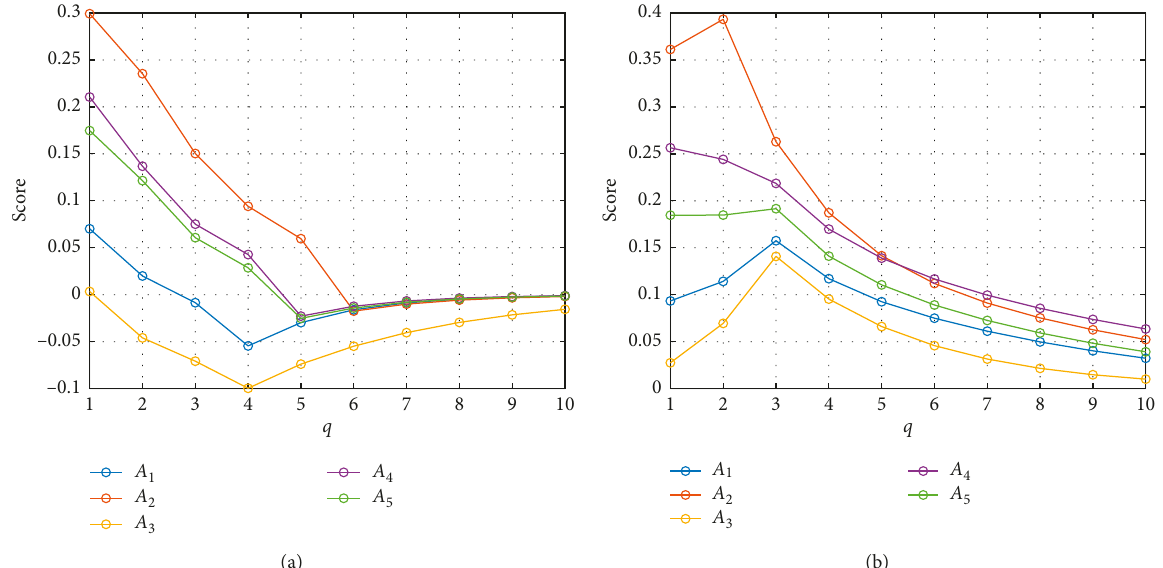
Figure 1: The results of Experiment 2. Scores of the five companies calculated by (a) qROFWAHMM and (b)